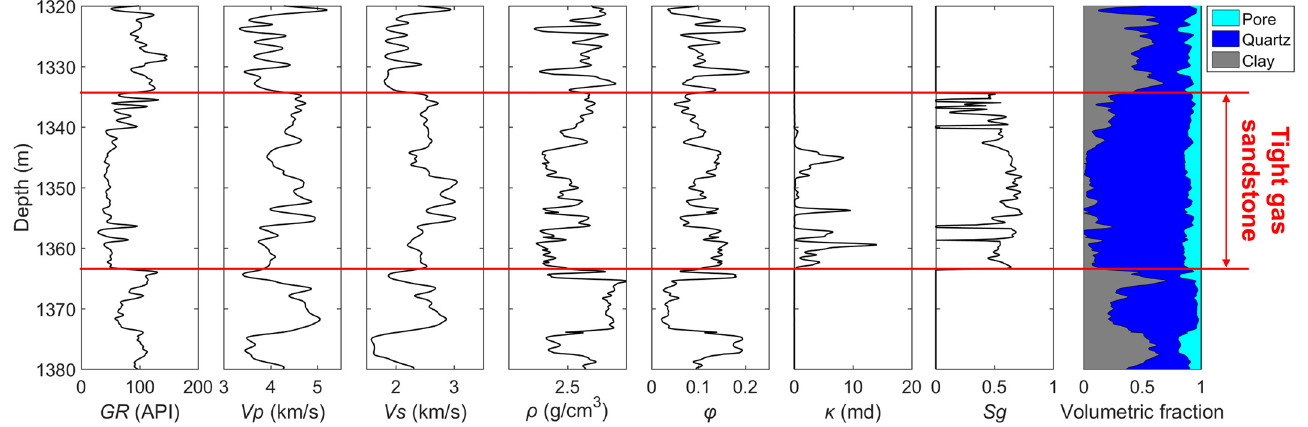
Figure 5. Logging data for the gas ‐ bearing tight sandstones from the study area.